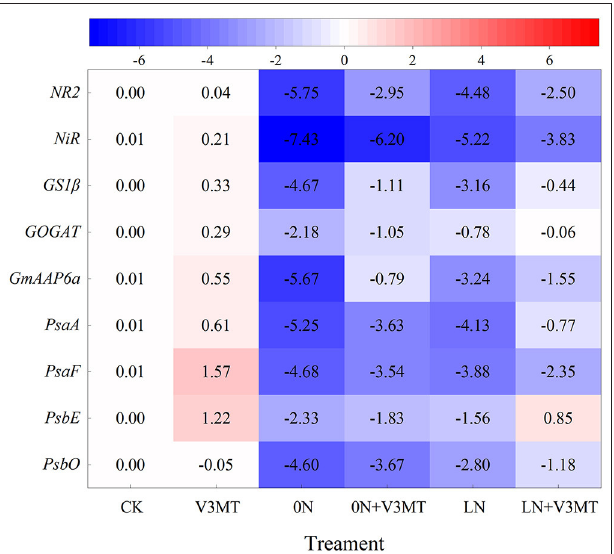
0N + V3MT and 0N + R5MT were 32.88 and 27.40%,